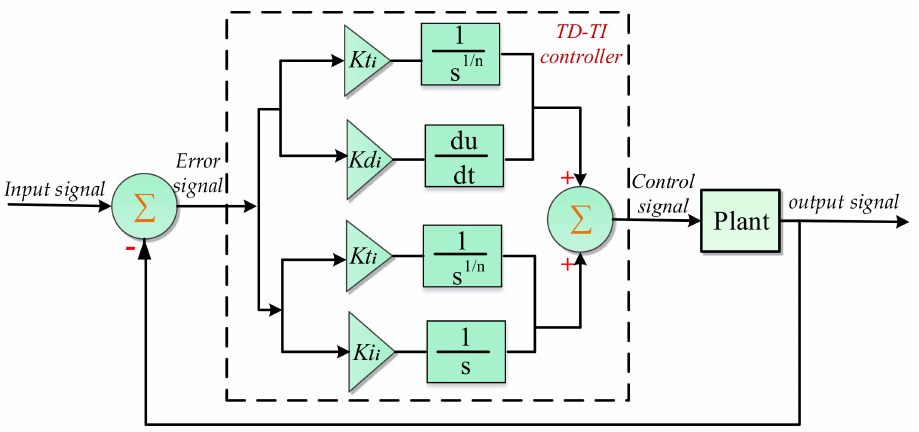
Figure 8. The construction of the proposed combining tilt-derivative and tilt-integral